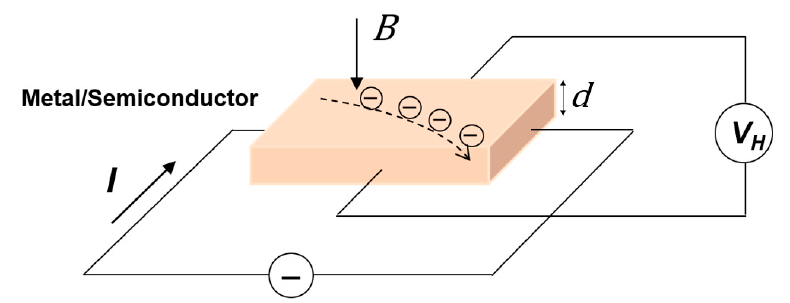
Figure 1. Working principles of Hall